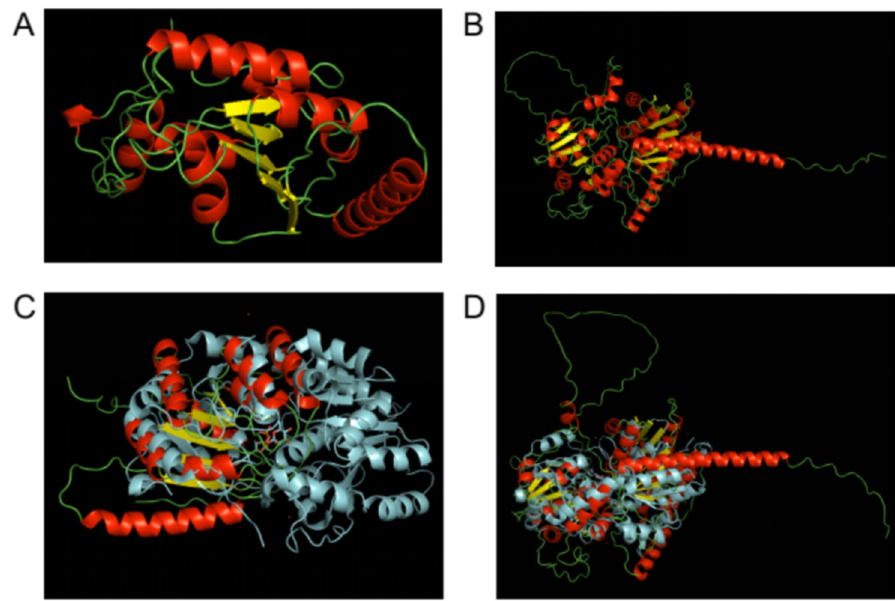
Figure 4. In silico structural analysis of Sporothrix schenckii Rht1 and Rht2 proteins. Alphafold2 predicted models for Rht1 ( A ) and Rht2 ( B ) and rendered on PyMol. Secondary structures are color- coded as follows: alpha helixes red, beta sheets yellow, coils green. Alignments (atoms superimposed) of the predicted 3D model to Arabidopsis thaliana rhamnosyltransferase UGT89C1: Rht1/UGT89C1 panel ( C ) and Rht2/UGT89C1 panel ( D ). Rht1 ( C ) and Rht2 ( D ) are colored according to secondary structure, while UGT89C1 is shown in cyan.